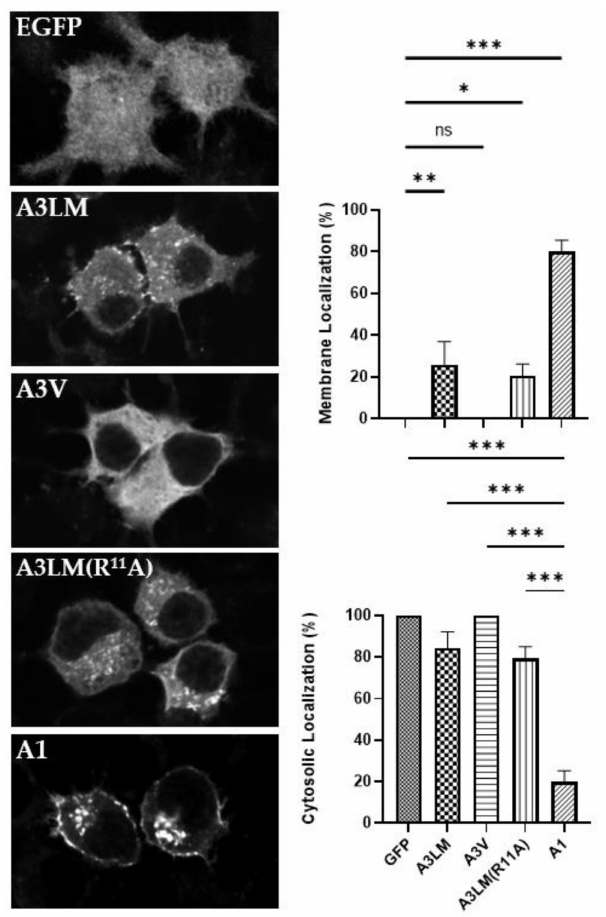
Figure 3. Intracellular localization of A3 N sequence variants. (Left) After overnight transfections, N2A cells were fixed with 4% paraformaldehyde and imaged for EGFP fluorescence (excitation 488 nm, emission 509 nm). Representative images show the steady-state localization of EGFP, EGFP- LC/A3 Loch Maree (A3LM), EGFP-LC/A3V (A3V), EGFP-LC/A3LM(R 11 A) (A3LM(R 11 A)), and EGFP-LC/A1 (A1). (Right) Percentage of EGFP membrane-bound or present in the cytosol. Ten ran- dom fields were selected and counted for membrane (Upper) or cytosolic (Lower) localization. Mean and SEM were evaluated, with ordinary one-way ANOVA with Dunnett’s multiple comparisons test using A3 LM as the control column: ns, not significant; * p < 0.01; ** p < 0.05; *** p <